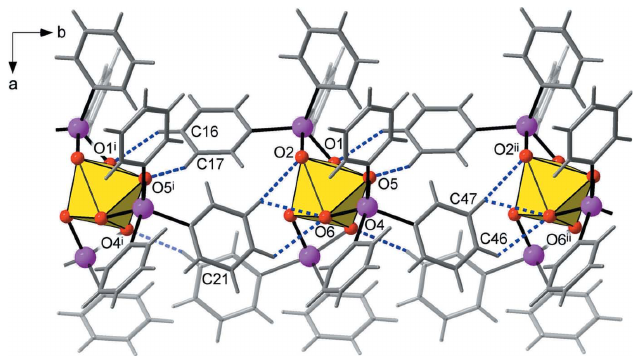
Figure 3 One-dimensional chains running along the b -axis direction, in which translation-related molecules of the title compound are linked by a series of weak C—H (cid:2)(cid:2)(cid:2) O hydrogen bonds (shown as dashed blue lines). [Symmetry codes: (i) x , y (cid:3) 1, z ; (ii) x , y + 1, z